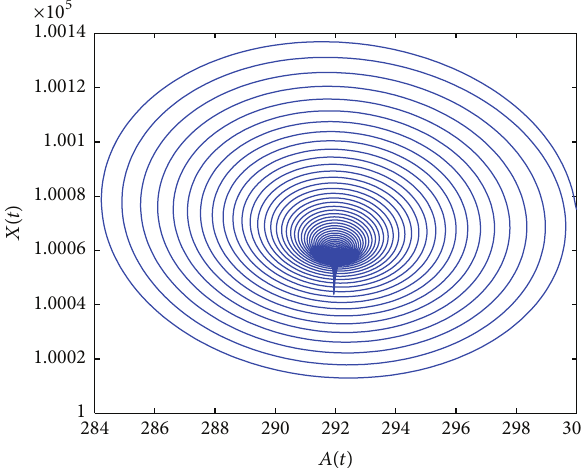
Figure 5: This corresponding phase plot of system (2a), (2b), (2c), and (2d) in 𝐴(𝑡) - 𝑋(𝑡)